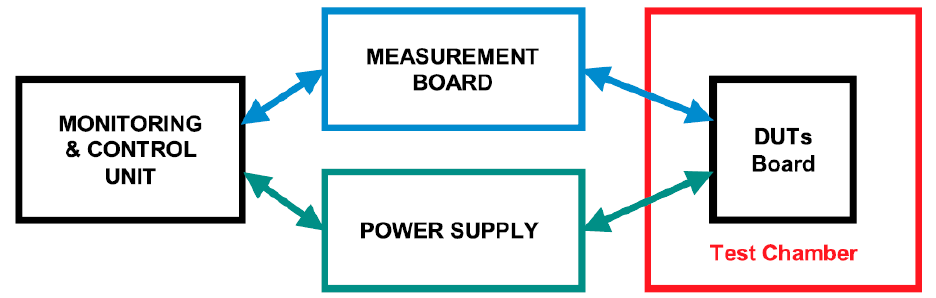
Figure 1. Schematics of a generic HV-THB test architecture. Figure reproduced with permission from [8].